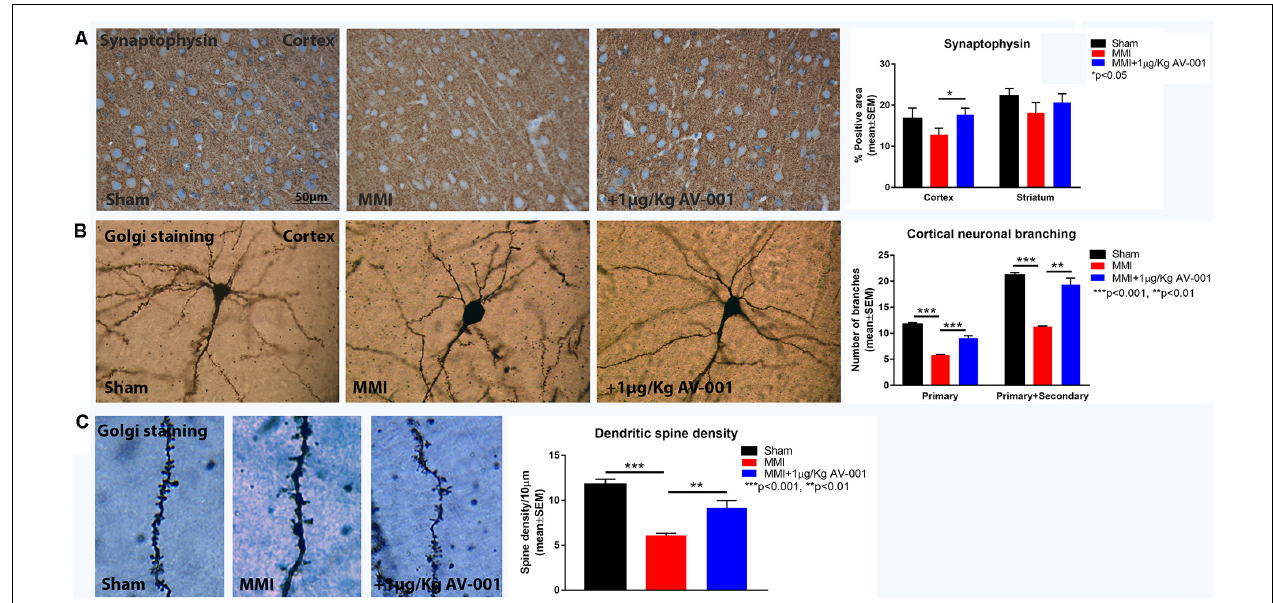
FIGURE 8 | AV-001 treatment significantly increases synaptogenesis in middle-aged rats subjected to MMI. (A) Representative images and quantification data of synaptic protein expression in the Cortex and Striatum. Treatment with 1 µ g/Kg AV-001 significantly increases Synaptophysin expression in the cortex compared to control MMI animals. (B,C) Representative images and quantification data of Golgi staining in the Cortex region of brain. MMI significantly decreases neuronal branching in the layer III of Cortex as well as decreases dendritic spine density compared to Sham control rats. Treatment with 1 µ g/Kg AV-001 significantly increases neuronal branching and dendritic spine density in the cortex region compared to control MMI